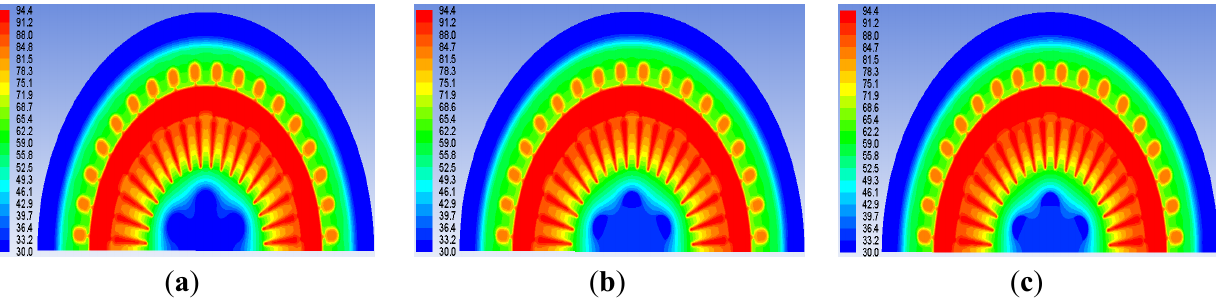
Figure 16. Thermal field distribution of three cross-sections: ( a ) the water inlet side; ( b ) the middle cross-section; and ( c ) the water outlet